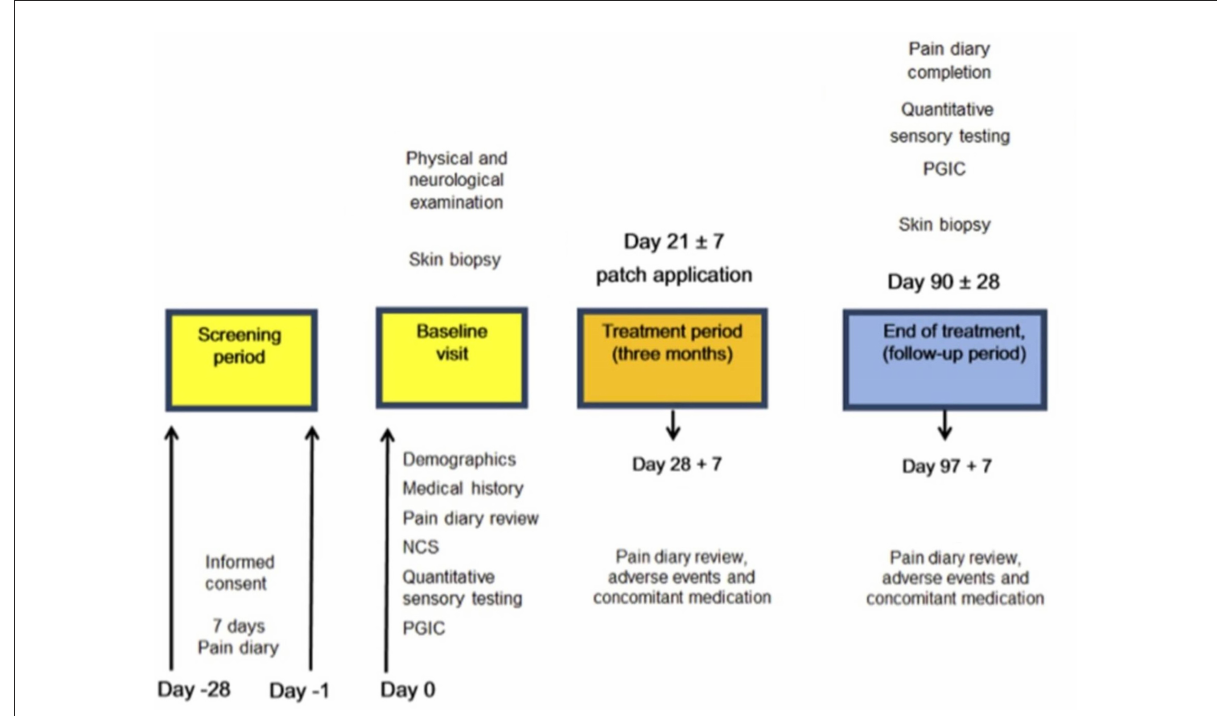
FIGURE2 Study flow diagram illustrating the sequence of assessment for participants in the study. NCS, Nerve conduction study, PGIC, Patient Global Impression of Change.